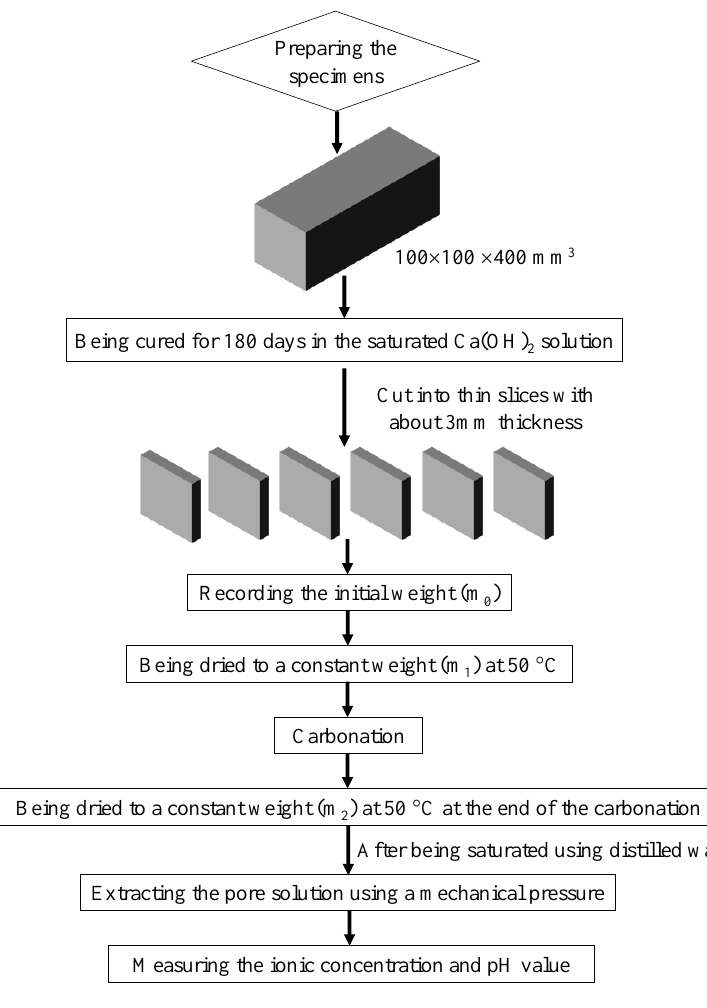
Figure 1. Schematic of the experimental procedure.